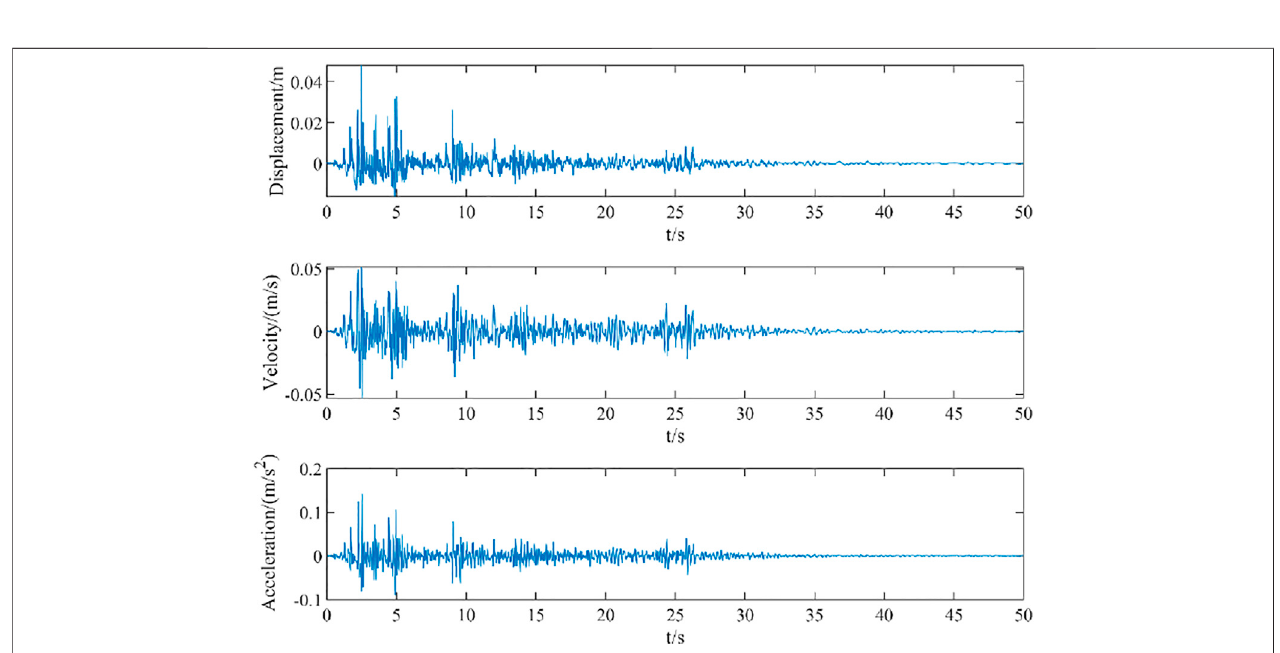
FIGURE 15 | Dynamic response of displacement, velocity, and acceleration output of damage truss